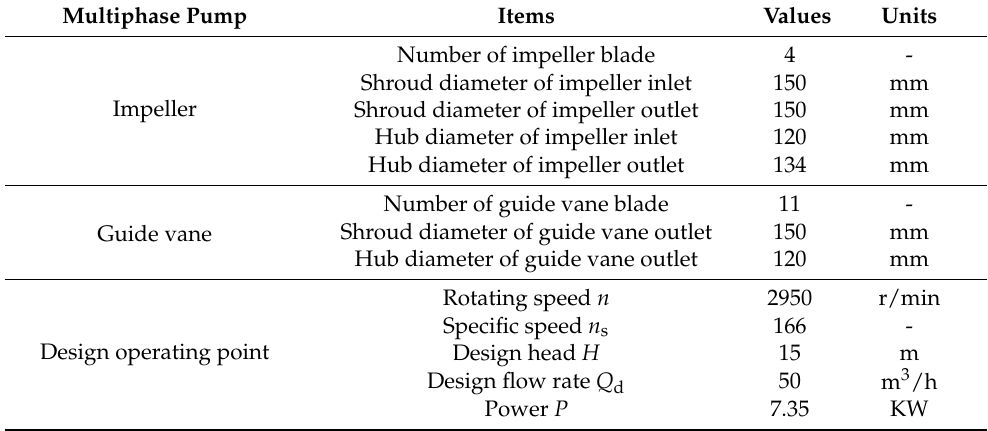
Table 1. Parameters of the multiphase pump.